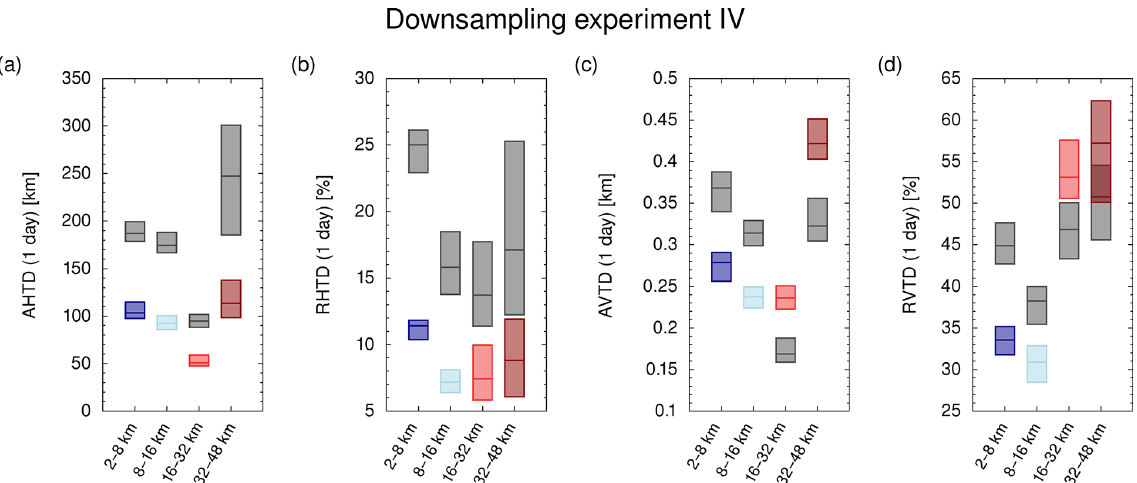
Figure 15. Global transport deviations of 1-day forward trajectories calculated with ERA5 data downsampled to the spatiotemporal resolution of ERA-Interim and ERA5 data at full resolution (blue and red bars). Transport deviations between ERA-Interim and ERA5 trajectories (cf. Fig. 8) are shown for reference (dark gray